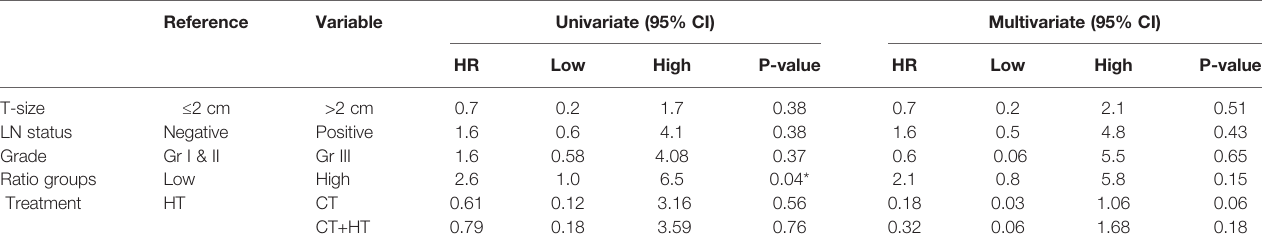
TABLE 3 | Cox proportional hazard models of AR/ER ratio groups with other clinical variables in the patients ≤ 50 years in our cohort.